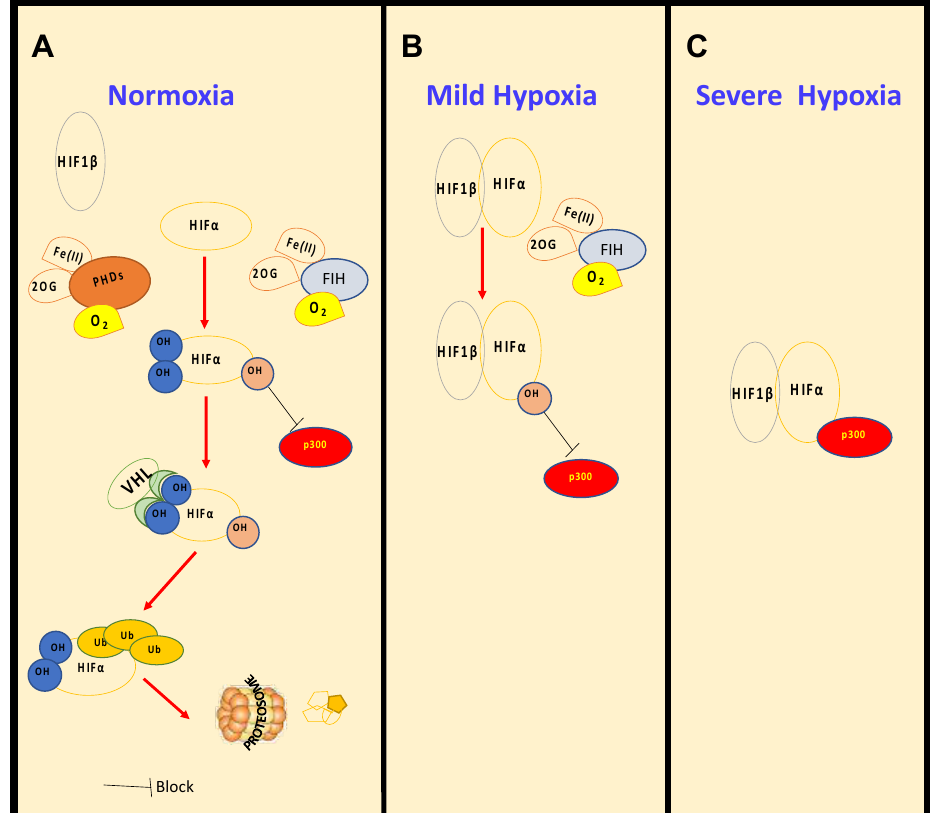
Figure 1. Regulation of HIF levels and activity in normoxia and hypoxia. Under normal oxygen conditions, ( A ), normoxia, HIF- α is constantly hydroxylated by PHDs and FIH. PHD-mediated hydroxylation increases binding affinity with the tumour suppressor VHL, which promotes ubiquitination and degradation by the proteosome. As oxygen levels decrease, in mild hypoxia (15–1% O 2 ) ( B ), PHDs are inhibited, HIF- α is stabilised, though still hydroxylated by FIH, binds to HIF-1 β and is able to induce transcription of certain target genes. With further reduction in oxygen levels, in severe hypoxia (<1% O 2 ) ( C ), FIH is also inhibited and HIF is able to become fully active by the recruitment of co-activators such as